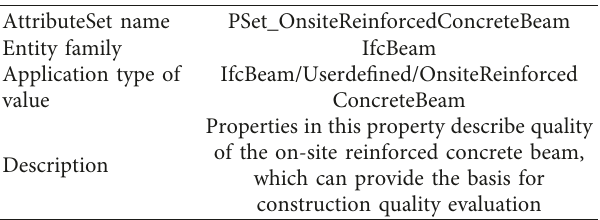
Table 5: The definition of IfcPropertySet of cast-in-place rein- forced concrete beam.